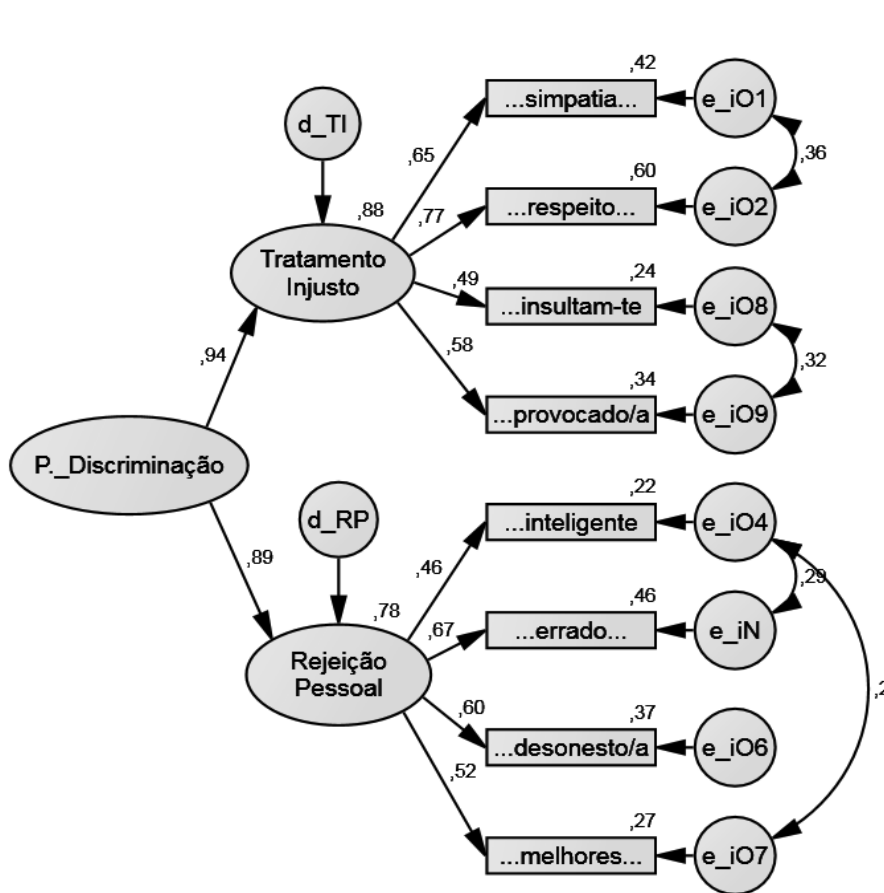
Figura 1 . Modelo hierárquico da Escala de Discriminação